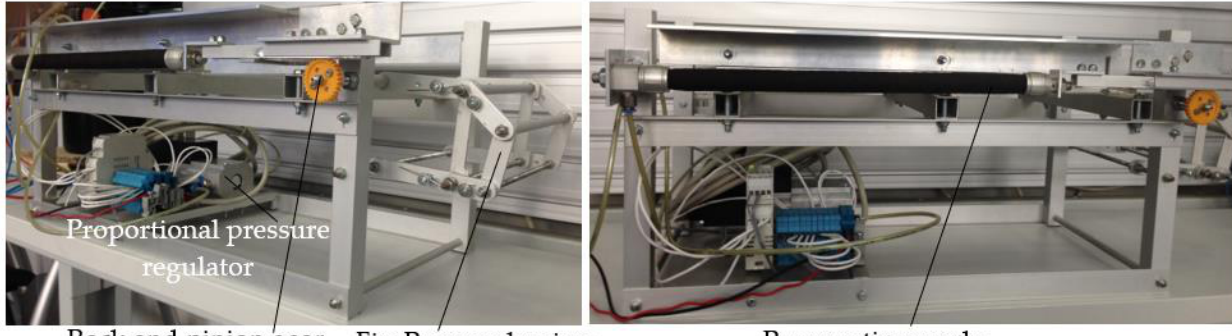
Figure 2. Construction of the rehabilitation equipment.